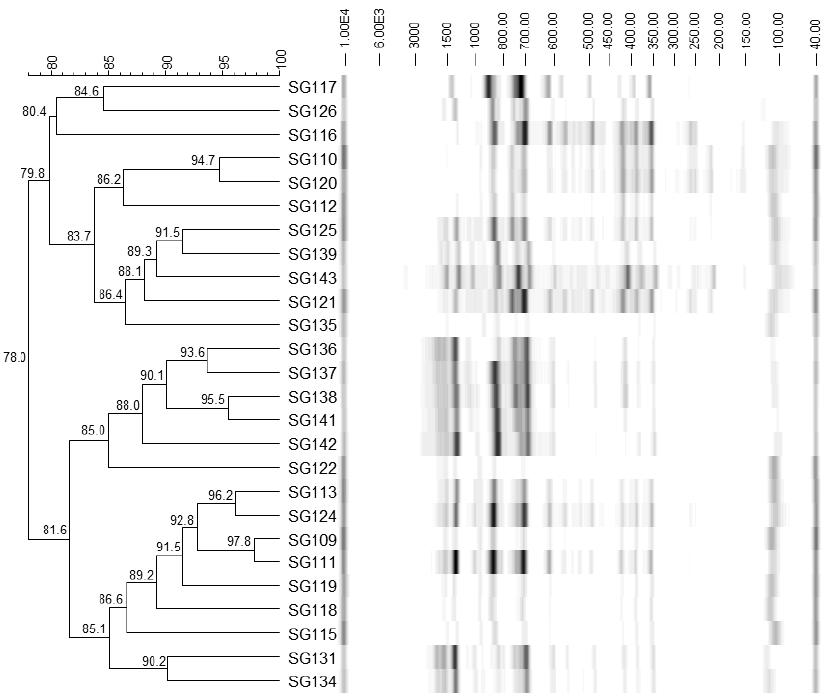
Figure 1. Phylogenetic tree ((GTG) 5 ) of the 28 lactic acid bacteria samples found in the sample of acidified wort, identified by sequencing (16S rDNA) as Lactobacillus amylolyticus . The primer 1492r (see Table 1) was used for the 16S rDNA gene sequencing. The results of BLAST are shown in Table 2. The sequences obtained with the 1492r primer gave ambiguous results: bacteria with the highest consensus score corresponded to the targeted species, L. amylolyticus , but were not significantly different from the bacteria with the second highest score, the closely related species L. amylovorus . The primers 16S-27r, 612r, and 926r were then additionally used for the 16S rDNA gene sequencing. According to the obtained sequences, the bacteria were identified as L.